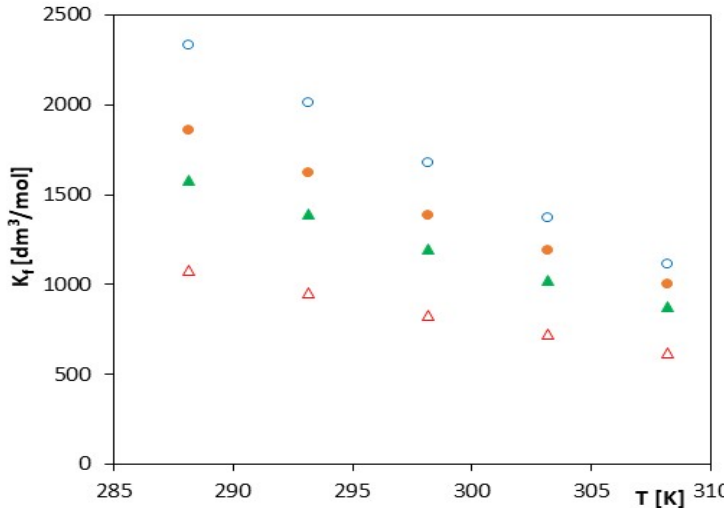
Figure 2. The plots of dependence of the K f (dm 3 /mol) formation constant in the T (K) function for α -cyclodextrin with all studied salts.: ∆ - trans -cinnamic acid; ▲ - trans - p -coumaric acid; ● - trans - caffeic acid; and ○ - trans -ferulic acid.